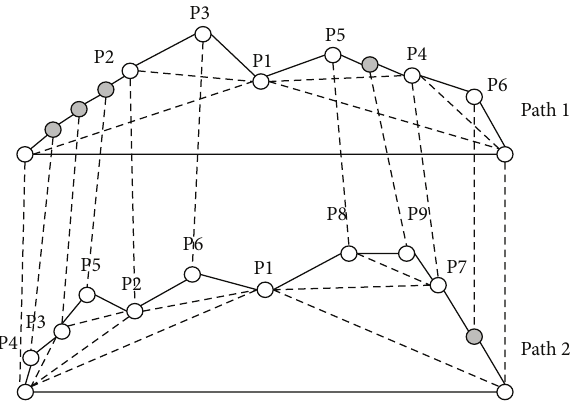
Figure 7: The corresponding path of Figure